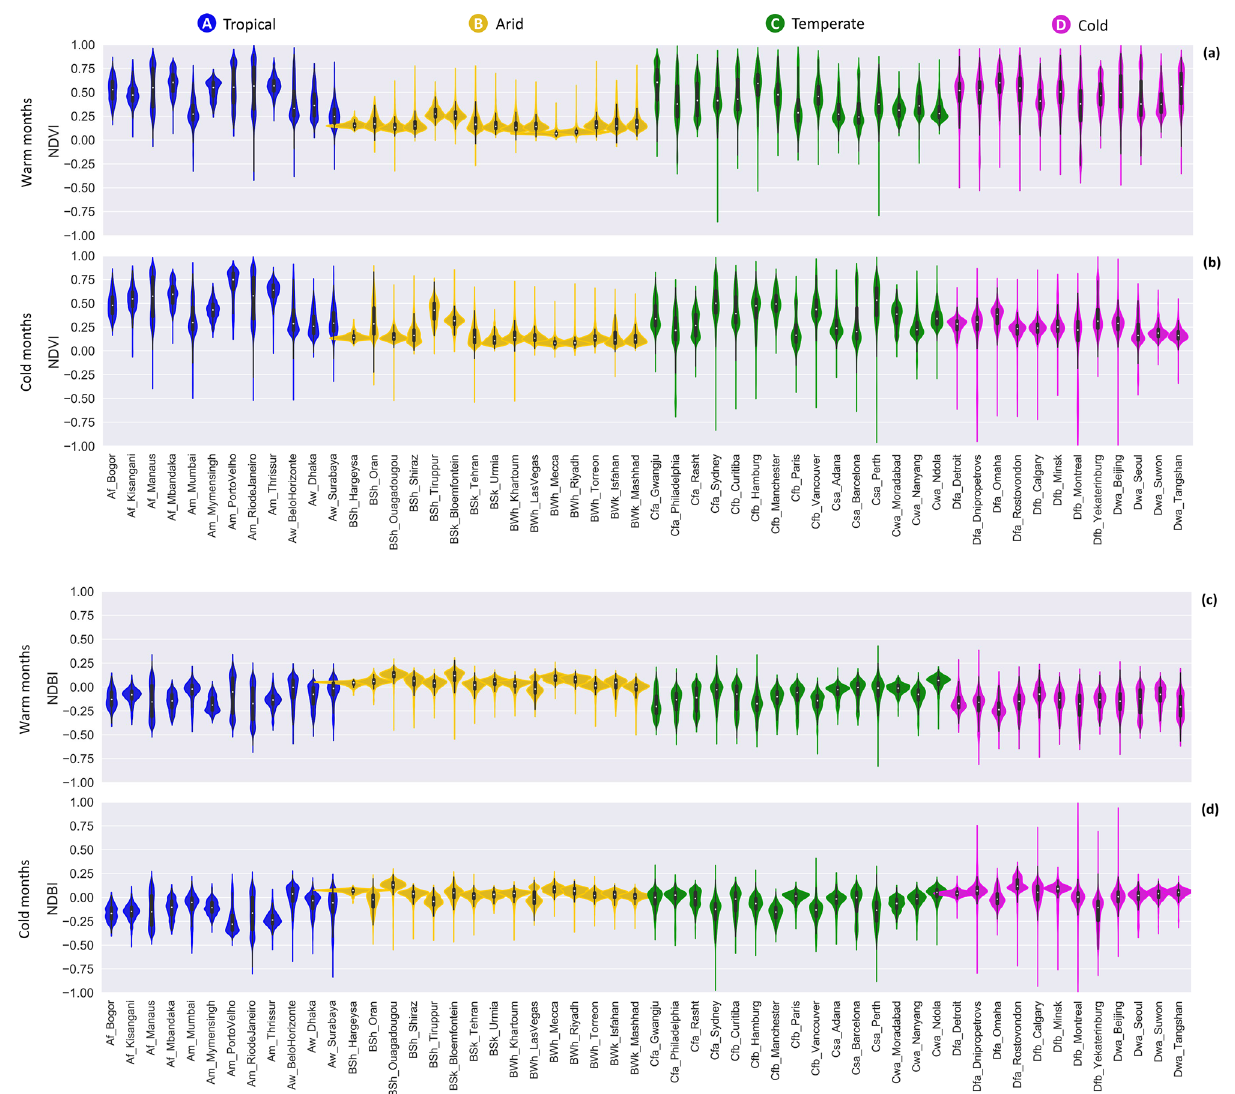
Figure 2. Range and distribution of land cover variable values for 54 cities. Coloured areas represent the distribution of the values. White dots within the violin plots depict the median values. ( a ) NDVI in warm months. ( b ) NDVI in cold months. ( c ) NDBI in warm months. ( d ) NDBI in cold months. Violin plots for NDWI and NDBaI are provided in Supplementary Fig.